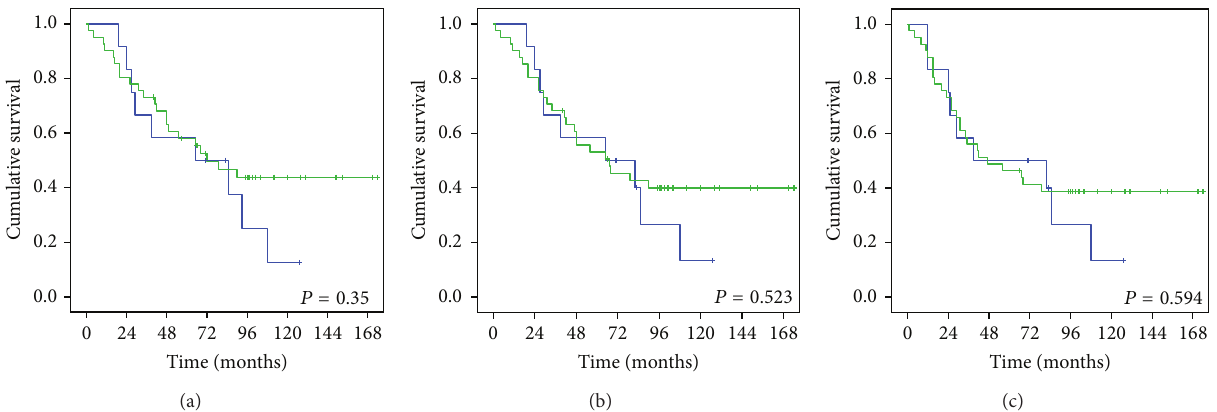
Figure 3: Comparison of (a) the 5-year overall survival, (b) the 5-year locoregional-free survival, and (c) the 5-year disease-free survival in the 3D-CRT group with cranial nerve involvement (green line) or without cranial nerve involvement (blue line).